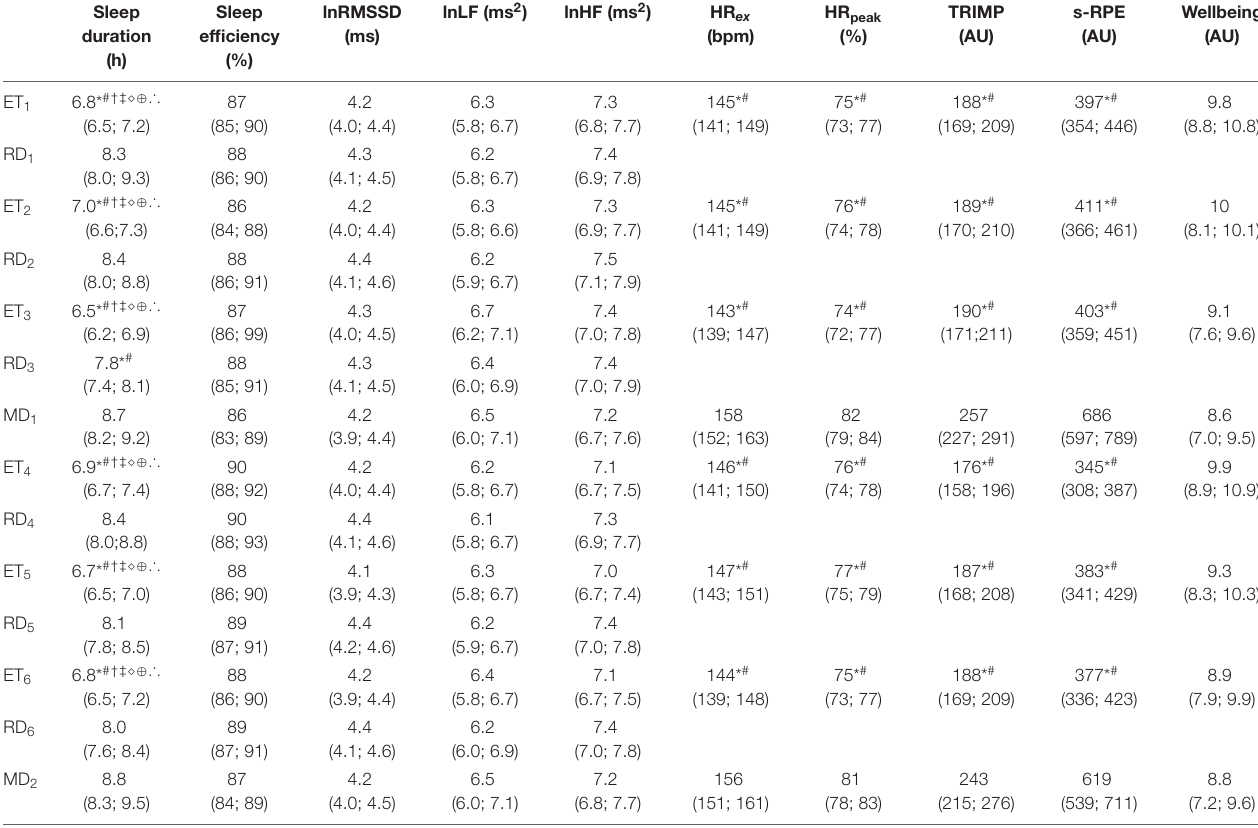
TABLE 1 | Players actigraphy sleep and nocturnal heart rate variability indices, training and match load parameters and perceived ratings of wellbeing during the 14 days of in-season competitive phase ( n = 34). Sleep